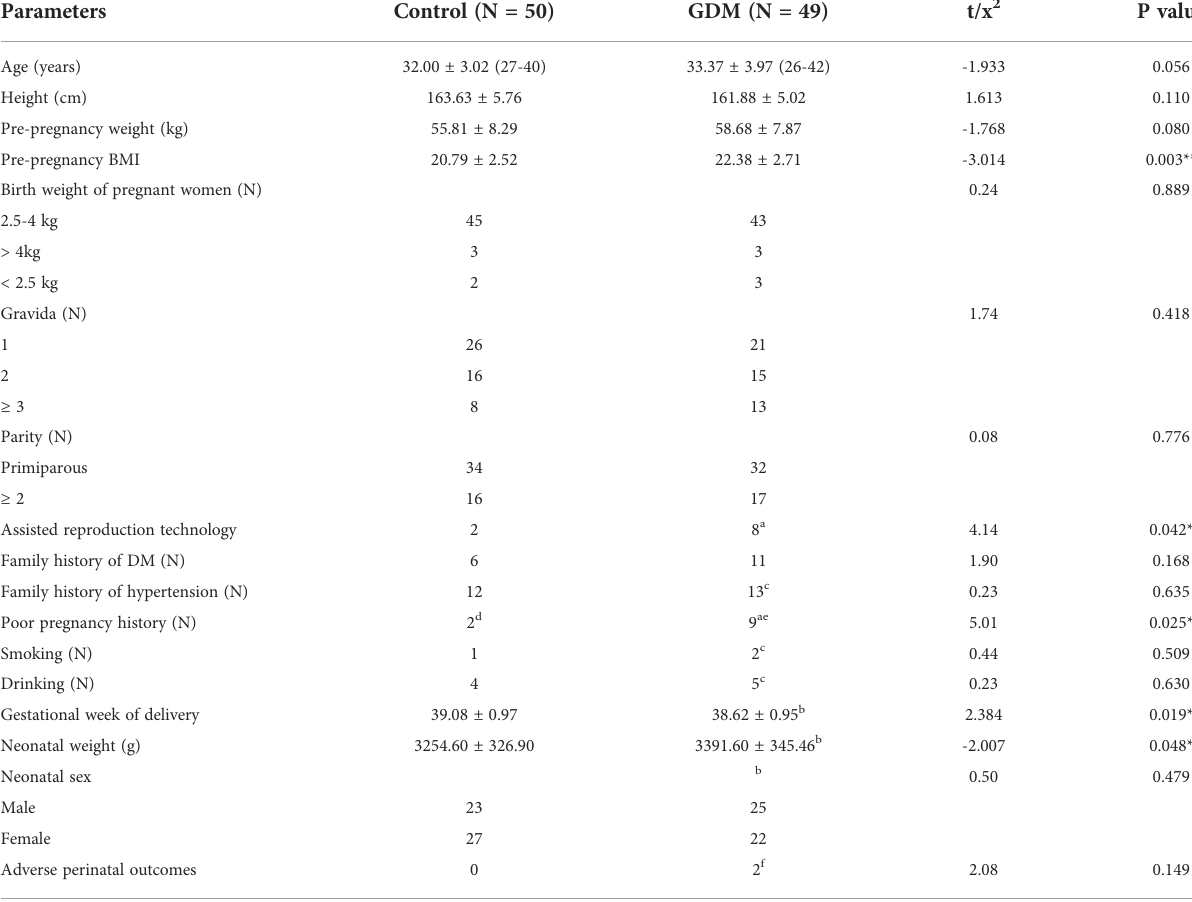
TABLE 1 The clinical characteristics of patients with gestational diabetes mellitus (GDM) and